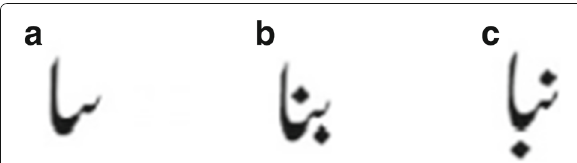
Fig. 15 a The same primary ligature forming different complete ligatures b ‘Bana’ and c ‘Naba’, due to the same dots (having the same position information) with different accessorder